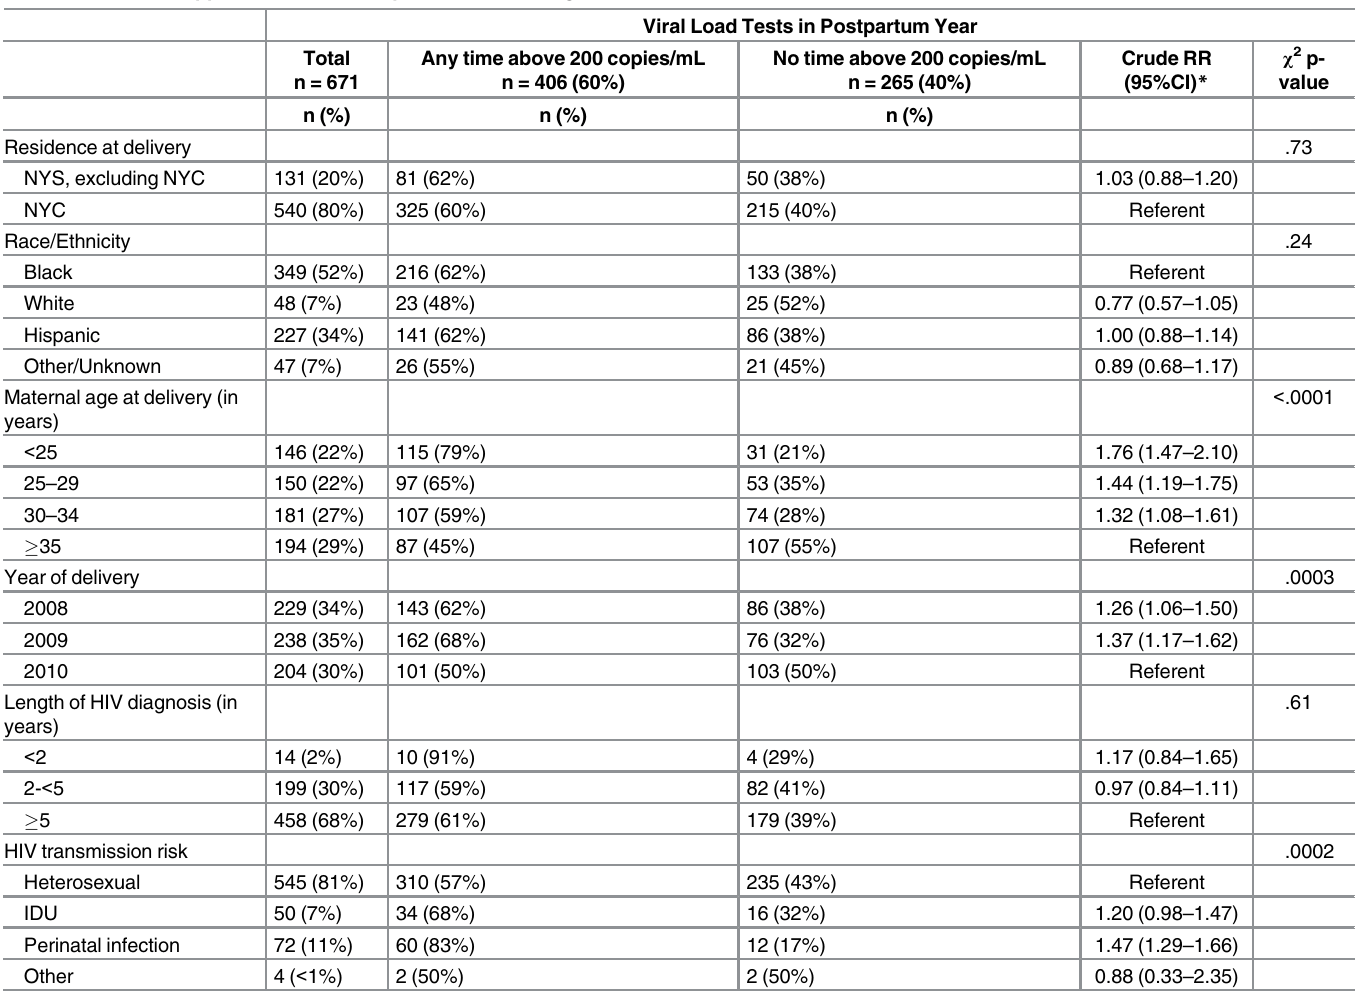
Table 4. HIV Viral Suppression in the Postpartum Year among Women with (cid:5) 2 HIV Viral Load Tests.